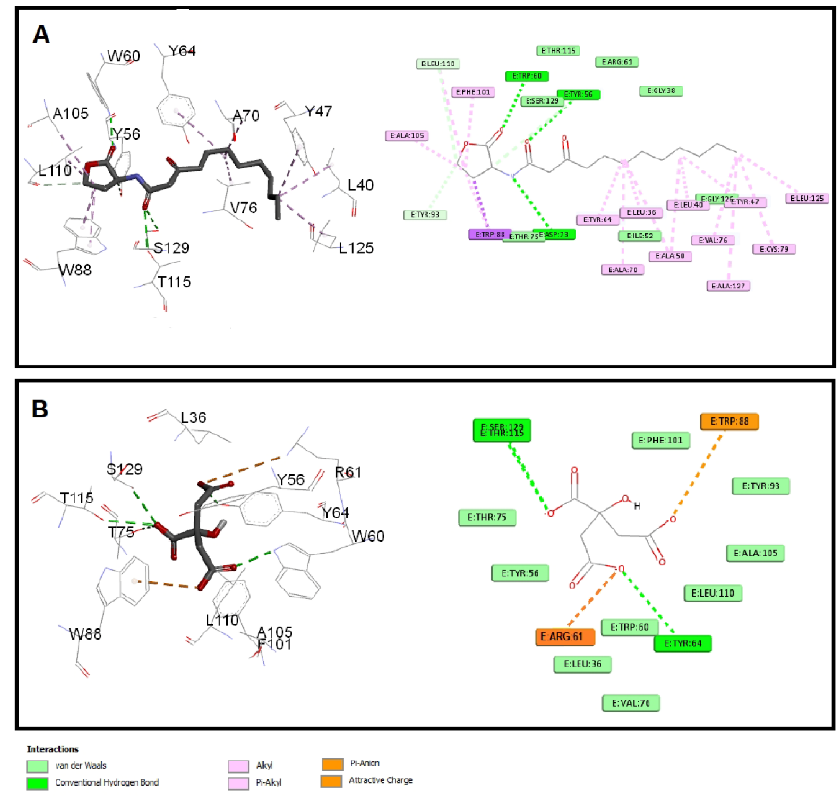
Figure 7. Molecular docking of ( A ) citrate and ( B ) C12-HSL into the active site of LasR protein 3D representation (left) and 2D schematic interaction (right). Citrate could bind with the LasR receptor and interfere with the P. aeruginosa QS systems.